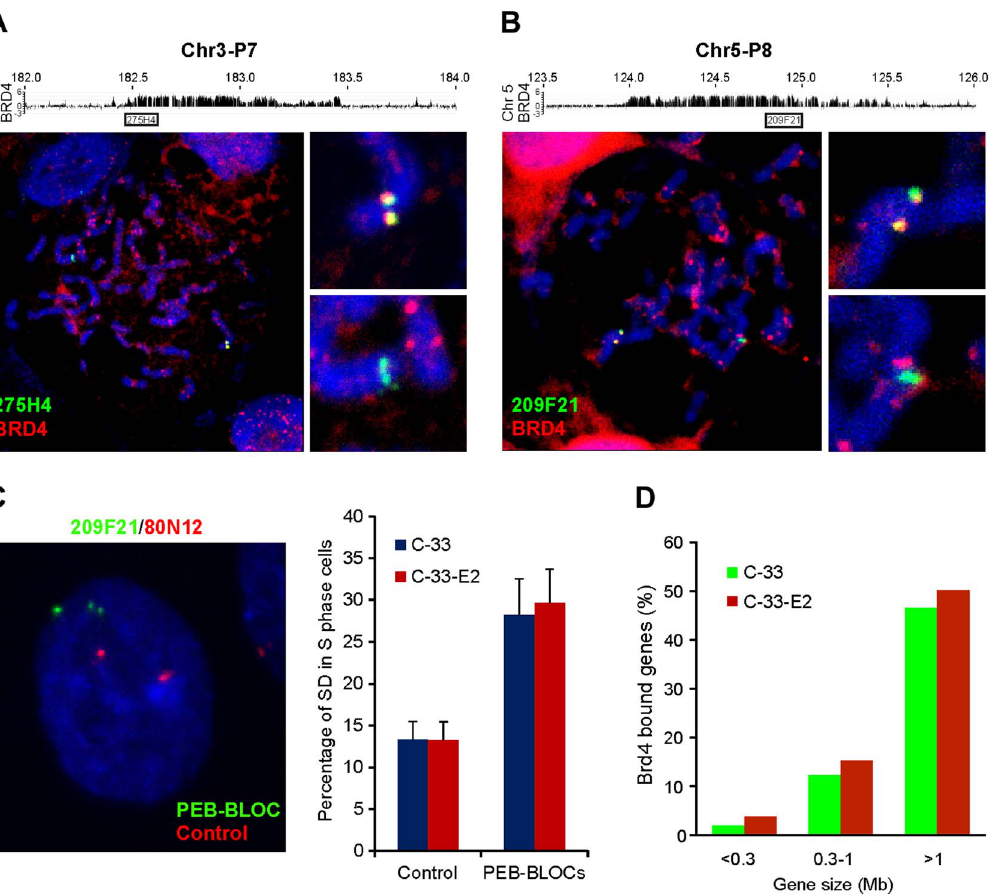
Figure 5. PEB-BLOCs share properties with fragile sites and are targets for chromosomal deletion. A, B. Chromosomes were spread from mitotic C-33-1E2 cells induced for E2 expression. BRD4 speckles were identified by immunofluorescence, fixed, and hybridized with PEB-BLOC specific FISH probes (107E21, 209F21, 274H4, or 365P10). A representative example is shown for probes 275H4 (A, Chr3-P7) and 209F21 (B, Chr5-P8). The BRD4 signal is red and the FISH signal is green. C. C-33-1E2 cells, induced for E2 expression were analyzed with specific FISH probes. PEB-BLOCs (209F21, 90I21, 274H4, 365P10, 1062A20; green) and control regions (80N12 and 379K17; red). Approximately 50 S-phase cells were analyzed for the SD pattern (one single, one double dot) FISH signals for each PEB-BLOCs or control region. This SD pattern represents asynchronous replication at the allele being examined. Average values and STDEV were calculated for two independent experiments on two control regions (80N12 and 379K17), and 4 PEB-BLOCs (Chr3-P7, Chr5-P8, Chr10-P4, Chr12-P3). D. Correlation between gene size and overlapping PEB-BLOC. The overlap was calculated for a region encompassing the gene body plus 5 kb upstream.